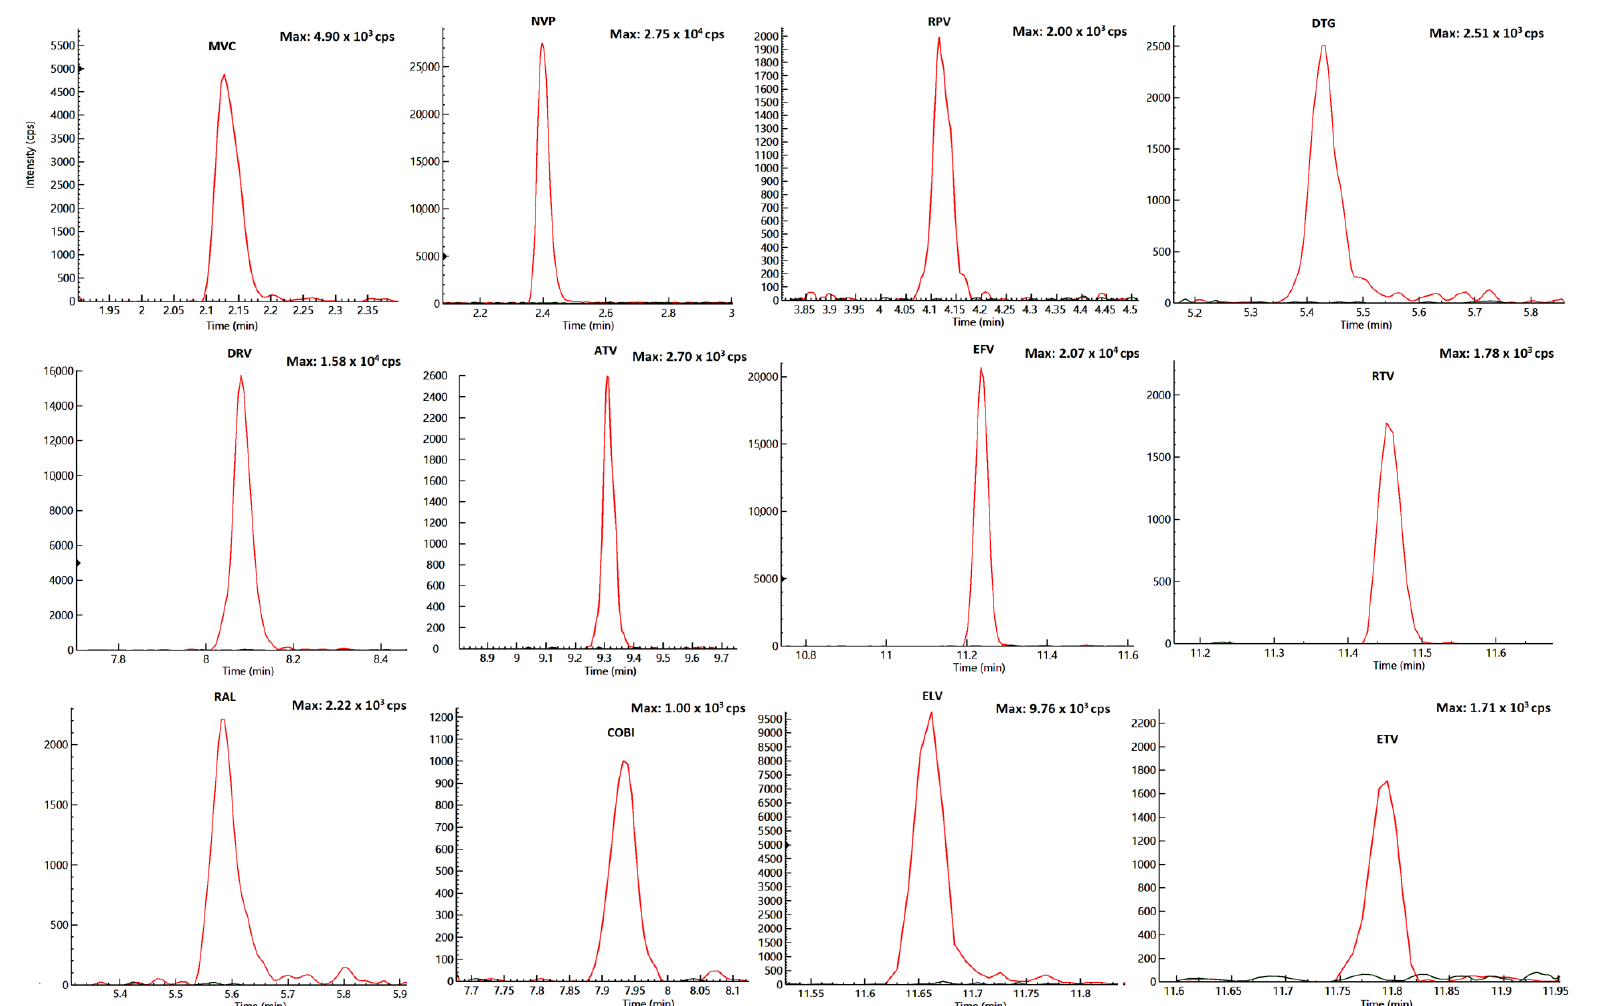
Figure 2. Overlaid chromatograms of blank peripheral blood mononuclear cells (PBMC) (STD 0) and LOD (limit of detection) for each drug.